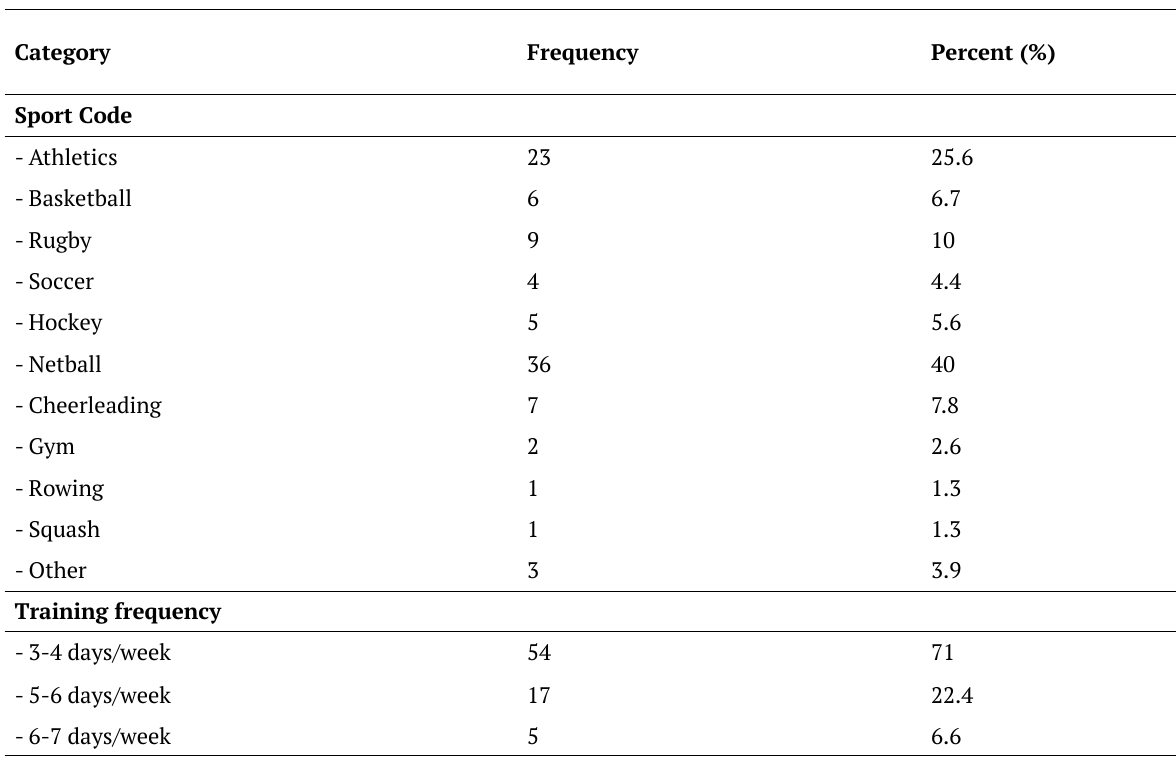
Knowledge of Hormonal